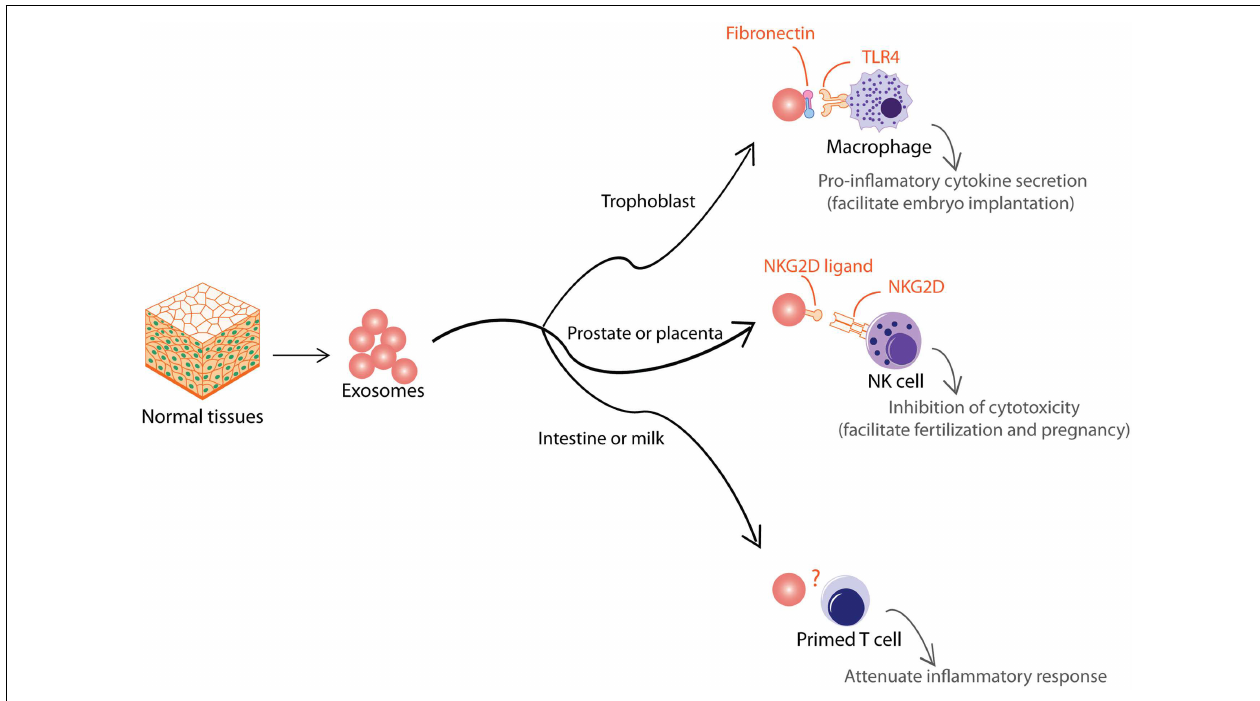
FIGURE 4 | Exosomes from normal tissues are shown . Normal tissue-derived exosomes exert multiple immune-modulatory activities to support normal physiological processes such as embryo implantation, fertilization, pregnancy, and oral